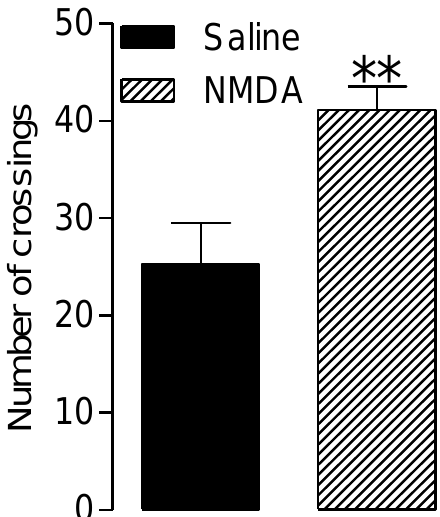
Figure 4. Effect of NMDA on the number of crossings between the two plates in the two temperatures choice test. Sham-exposed and RF-EMF-exposed groups were tested following i.t. saline or NMDA injection. As there was no BASAR or restraint effect, data were pooled for each pharmacological treatment. ** p < 0.01, the NMDA-treated rats crossed the plates more frequently compared to the saline treated rats.